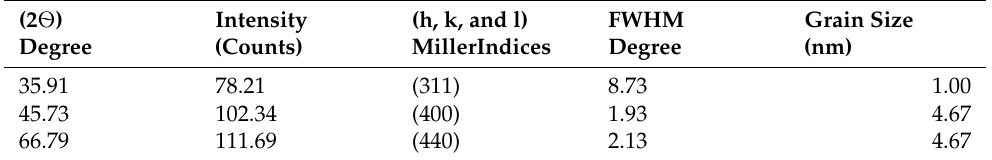
Table 1. Size distribution